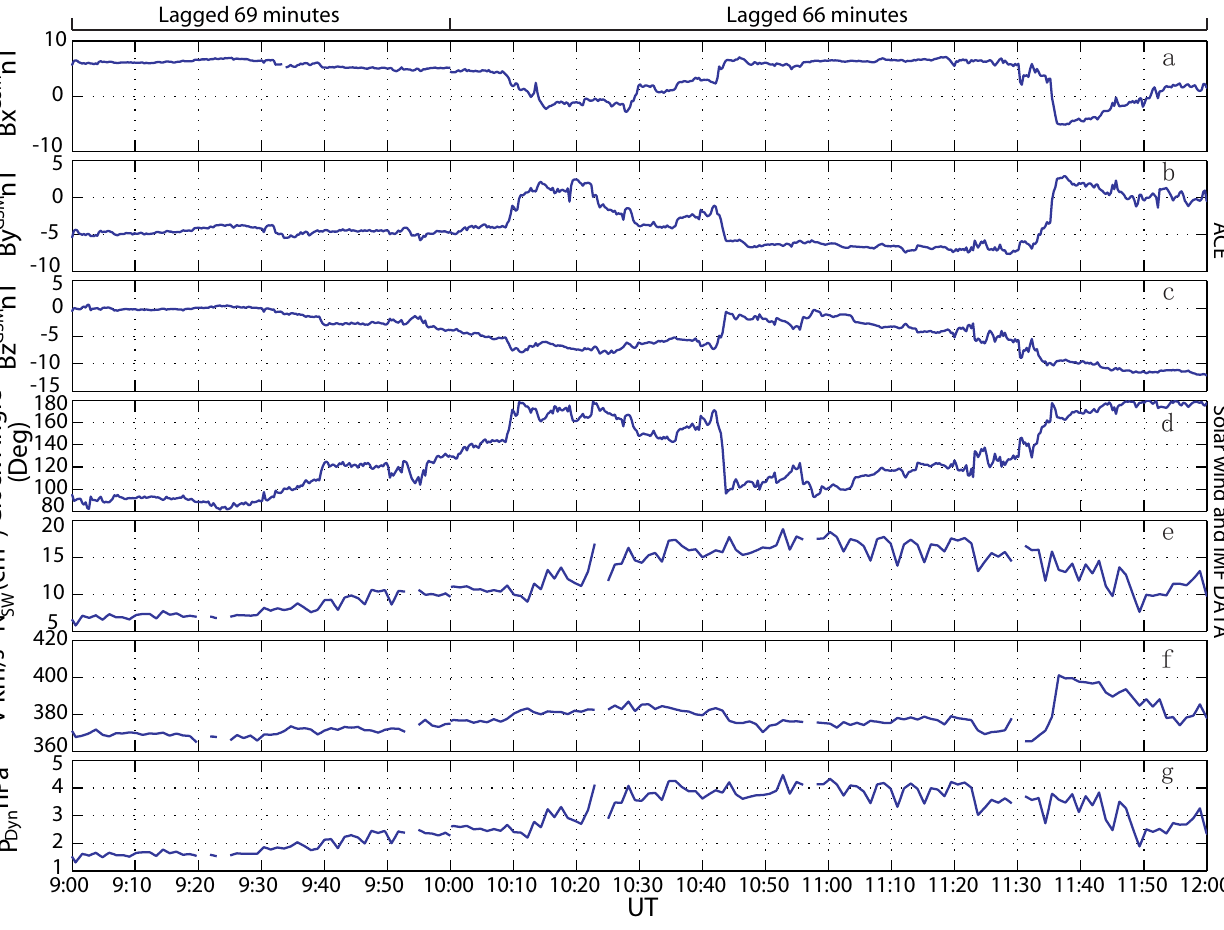
Fig. 1. An overview of the solar wind and IMF conditions measured by the ACE satellite. Parameters shown are IMF components (a) B X , (b) B Y , (c) B Z , (d) IMF clock angle, (e) solar wind plasma number density, (f) solar wind speed, and (g) solar wind dynamic